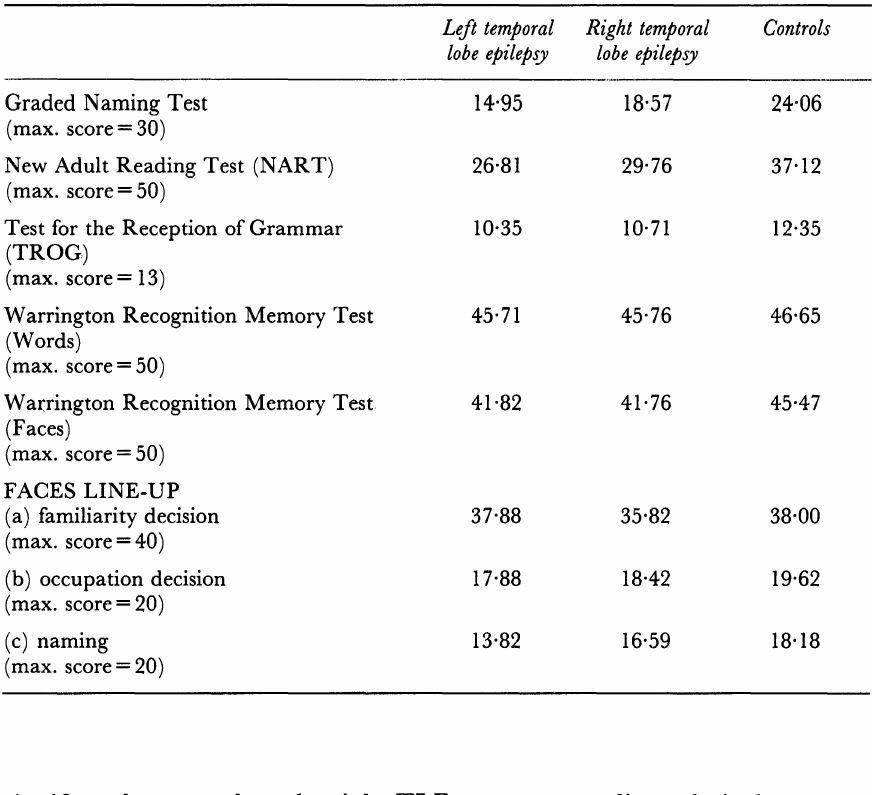
TABLE 1. Mean scores for left and right temporal lobe epilepsy patients and non-epileptic control subjects on tests of word and face